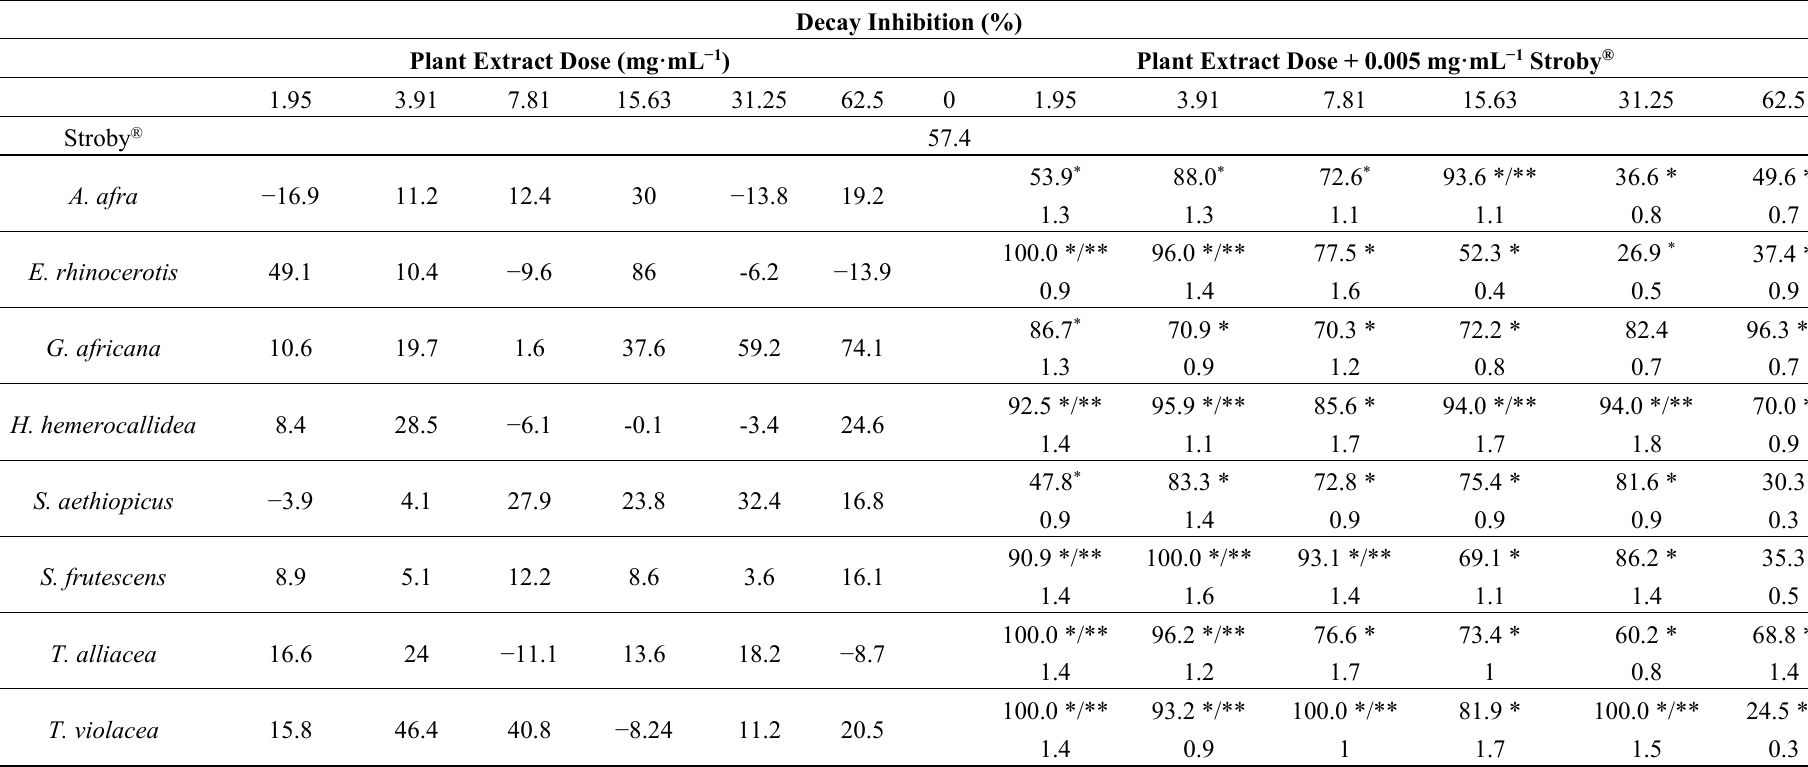
Table 2. Percentage inhibition of grey mold decay on Granny Smith apples inoculated with conidia of B. cinerea , and the relative level